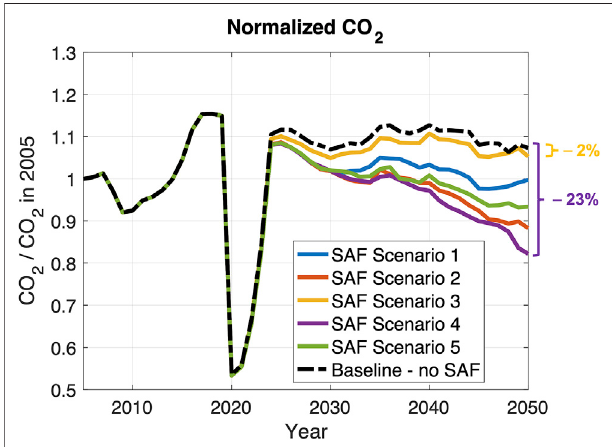
FIGURE 9 | Normalized fl eet-level CO 2 emissions for SAF scenarios (considering passenger demand recovery to pre-COVID-19 levels by 2024 and GDP slowdown to 75% until 2030); biofuel emission intensity: 2.312 lb CO2-equivalent per lb consumed fuel; CJF emission intensity: 3.67 lb CO2-equivalent per lb consumed fuel.